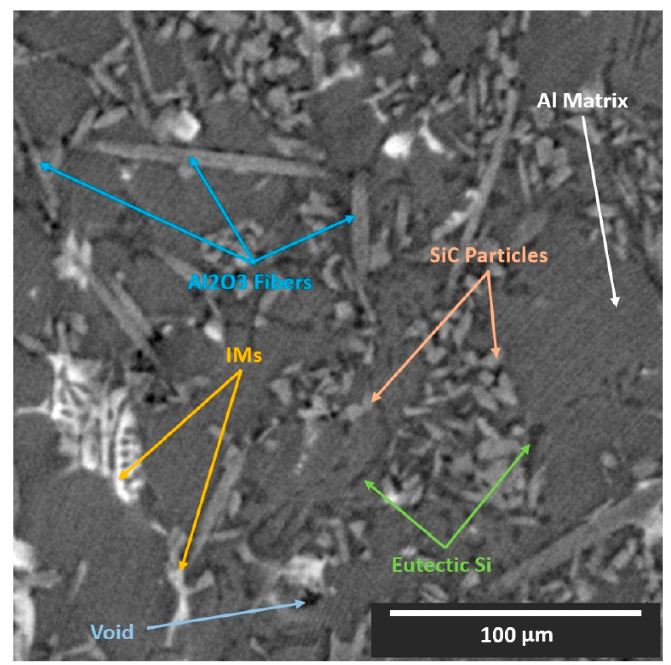
Figure 1. XCT reconstruction slice (XY-plane view) of the AlSi12CuMgNi MMC.